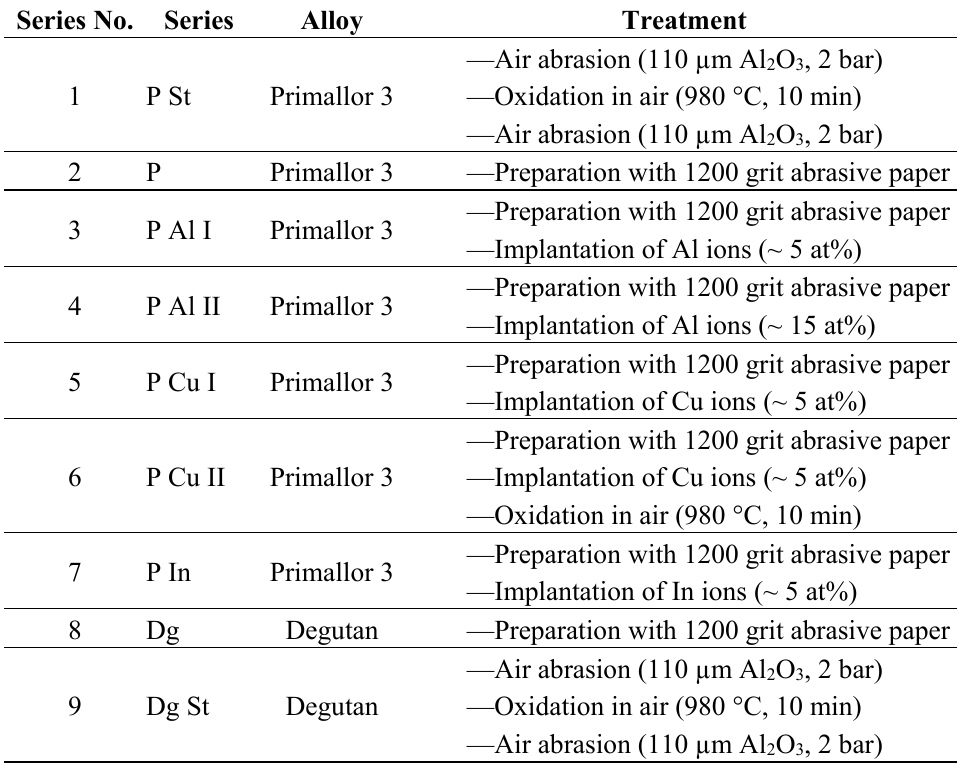
Table 2. Summary of the various specimen treatments. The abbreviation “St” in Series 1 and 9 stands for standard treatment of the alloy surface, i.e. , in accordance with the manufacturer’s specifications, before application of the ceramic. at% = atomic